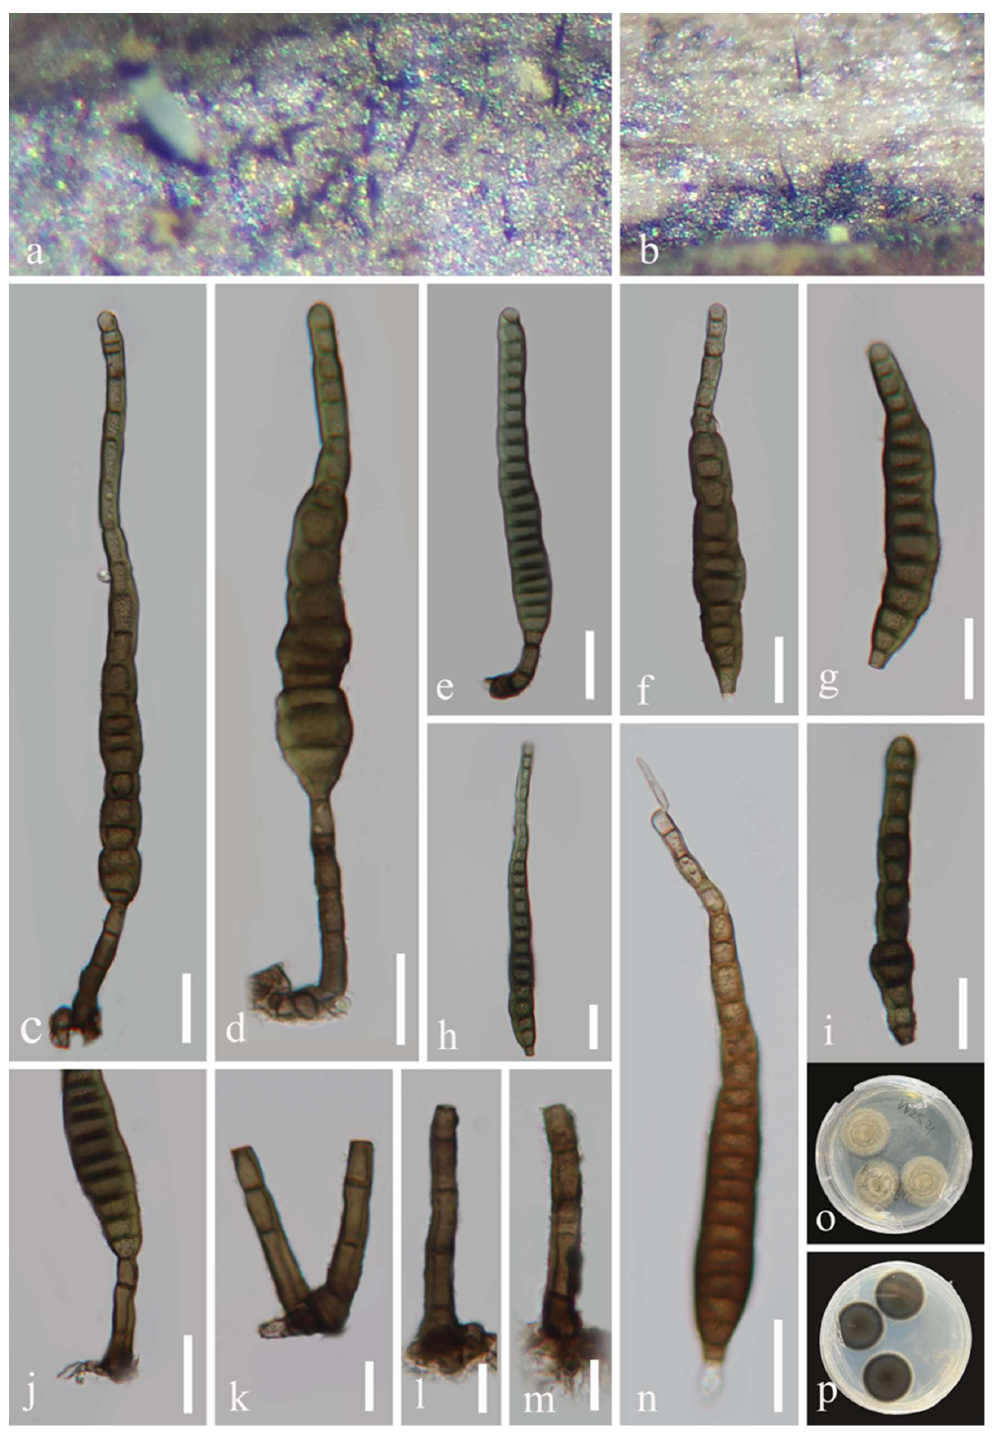
Figure 8. Distoseptispora wuzhishanensis (HKAS 123762, holotype). ( a , b ) Colonies on the host surface. ( c – e ) Conidiophores and conidia. ( f – i ) Conidia. ( j – m ) Conidiophores and conidiogenous cells. ( n ) Germinating conidium. ( o,p ) Colonies on PDA, o from above, p from reverse. Scale bars: ( c – j , n ) 20 μm, ( k – m ) 10 μm. Distoseptispora xishuangbannaensis Tibpromma and K.D. Hyde. Fungal Diversity 93: 82 (2018). Figure 9.